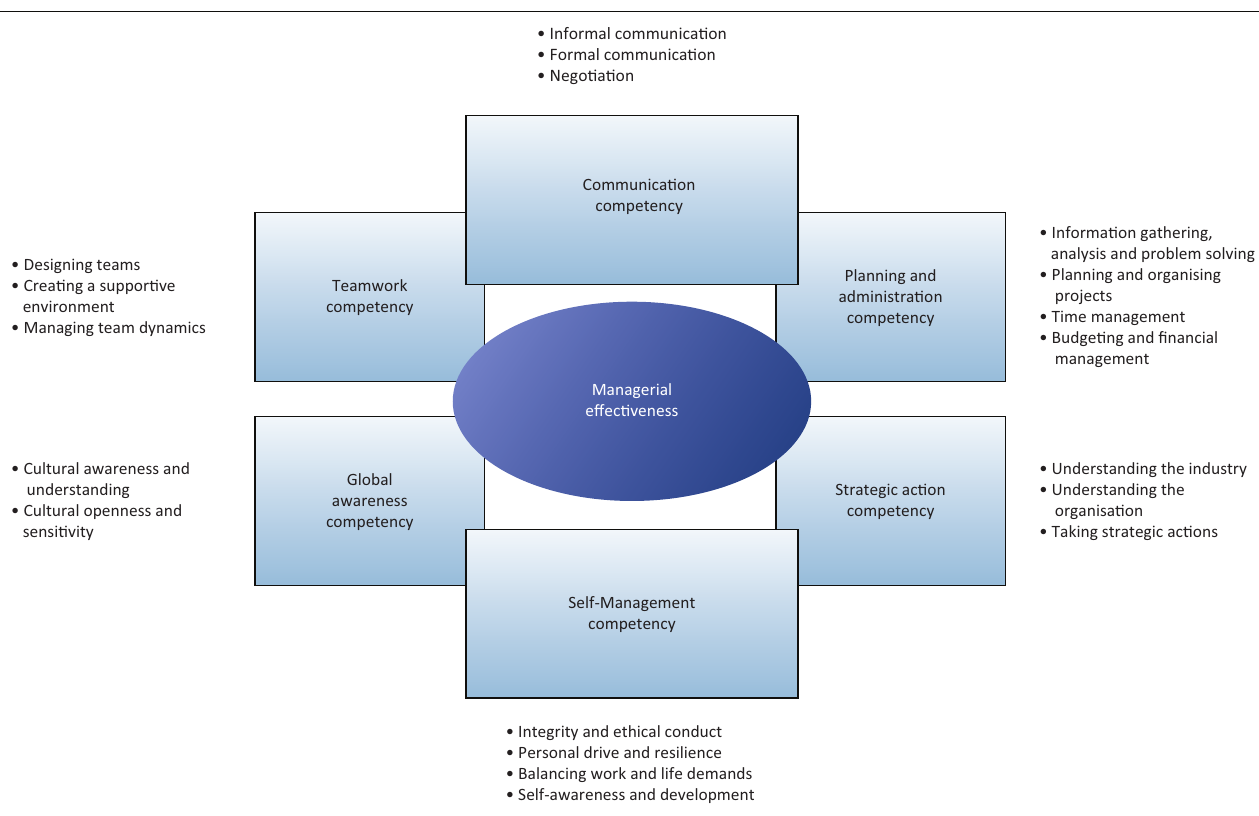
FIGURE 2: Six key managerial